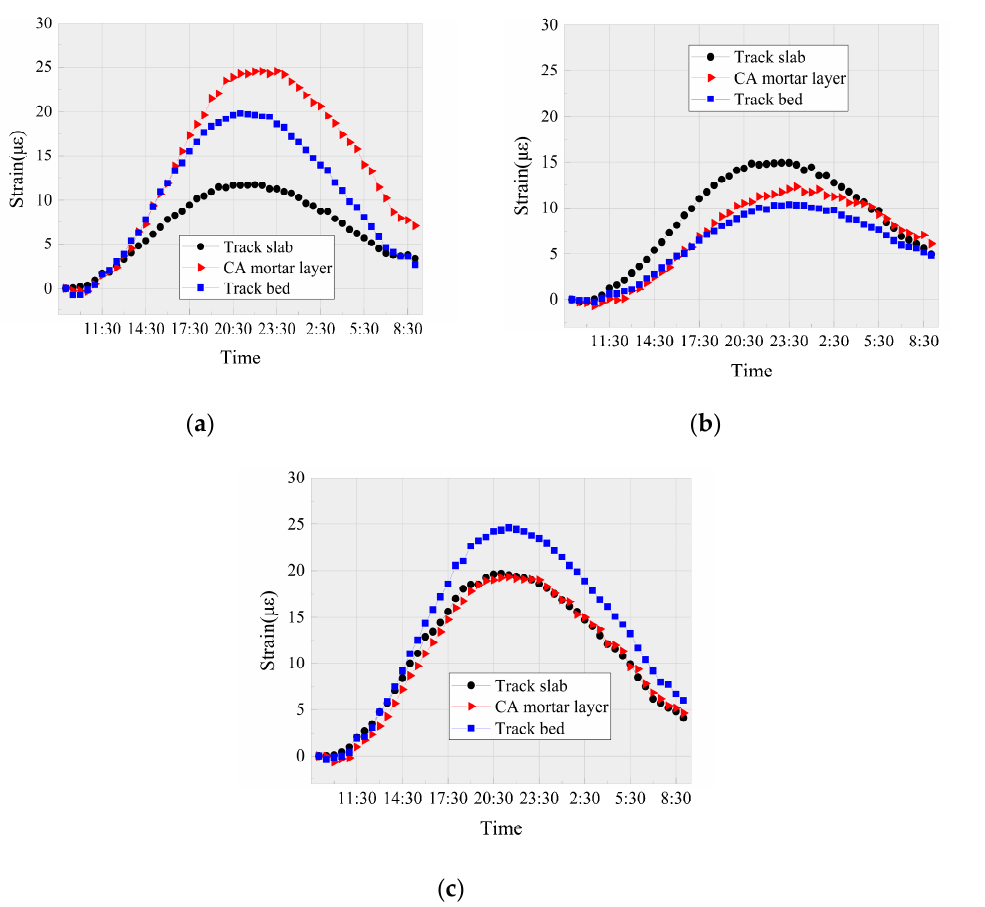
Figure 7. Strain-time history curve for the track system. ( a ) 0 L; ( b ) 1/2 L; ( c ) L.